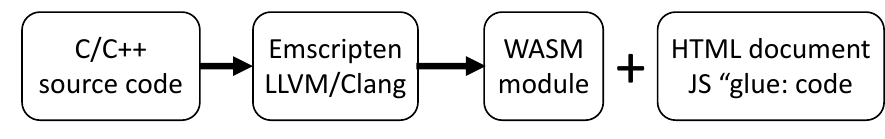
Figure 2. WebAssembly conversion